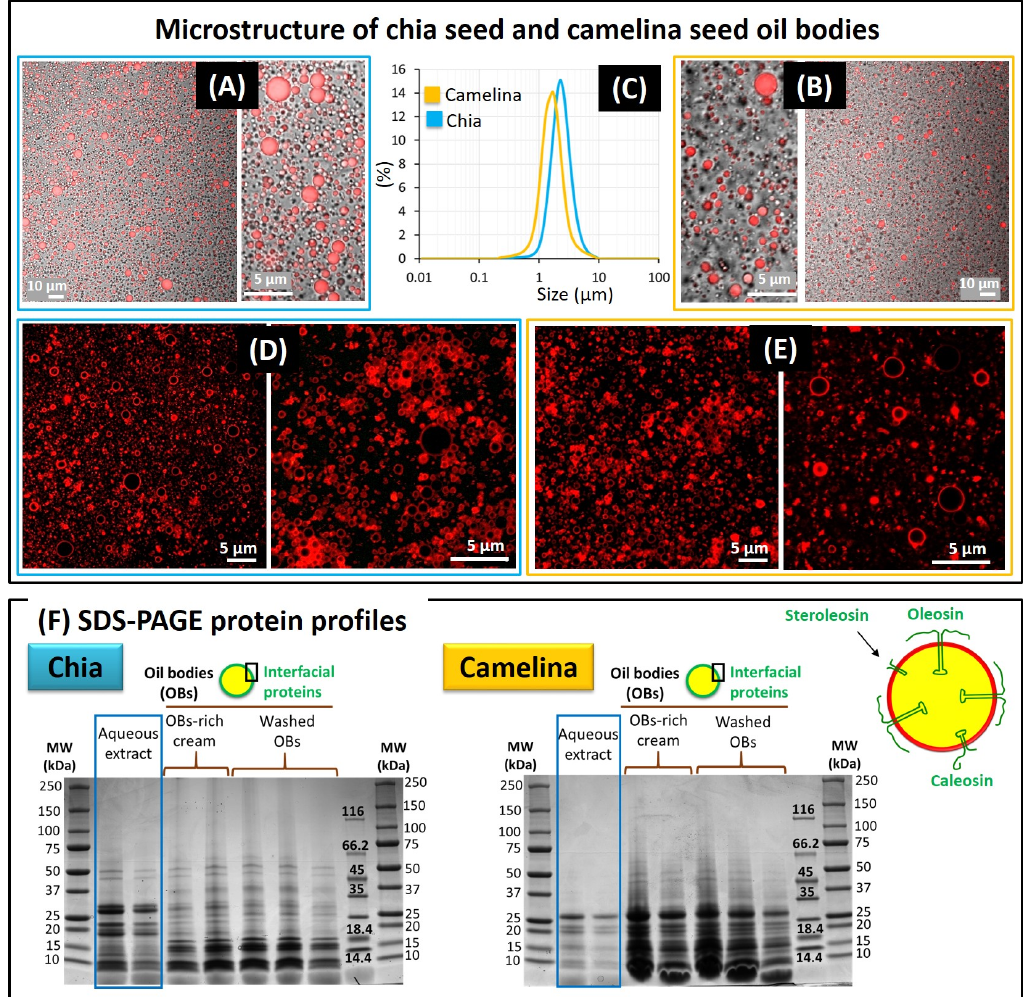
Figure 3. Microstructure of chia and camelina seed oil bodies (OBs) and identification of their interfacial proteins. ( A , B ) Confocal laser scanning microscopy (CLSM) combined with DIC images showing chia ( A ) and camelina ( B ) seed OBs (red colour: triacylglycerol core labelled with Nile Red fluorescent dye). ( C ) Size distribution of the chia and camelina seed OBs measured by laser light scattering; ( D , E ) CLSM images showing the monolayer of phospholipids around chia ( D ) and camelina ( E ) seed OBs (red colour: rhodamine-DOPE fluorescent dye); ( F ) SDS-PAGE protein profiles of chia and camelina seed aqueous extracts and OBs in the cream recovered after centrifugation and after washing (reducing conditions); (right) schematic representation of a OB with specific membrane proteins as indicated. Abbreviations: MW: molecular weight.